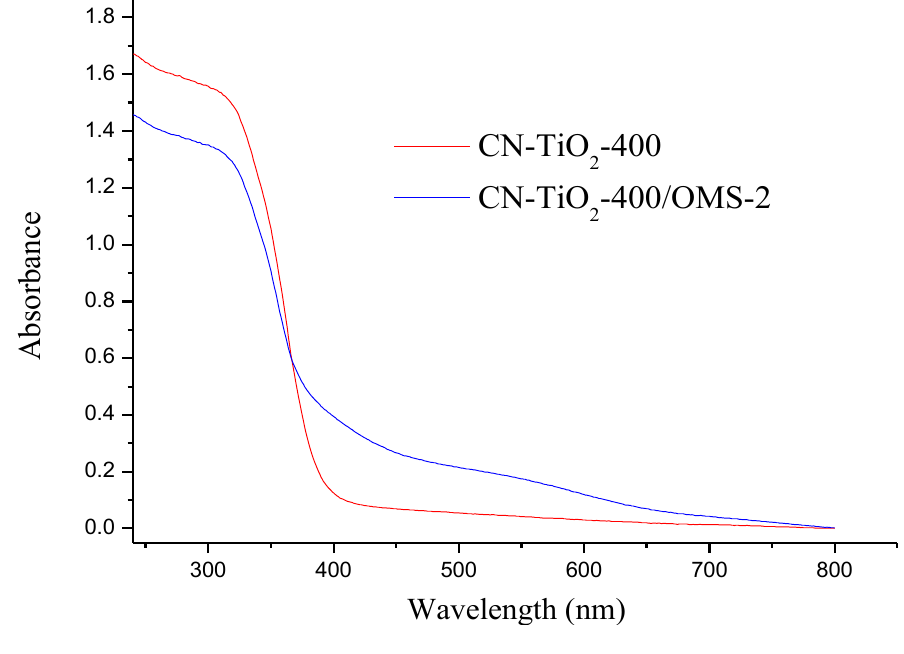
Figure 4. Optical properties of CN-codoped TiO 2 /OMS-2 sample compared to